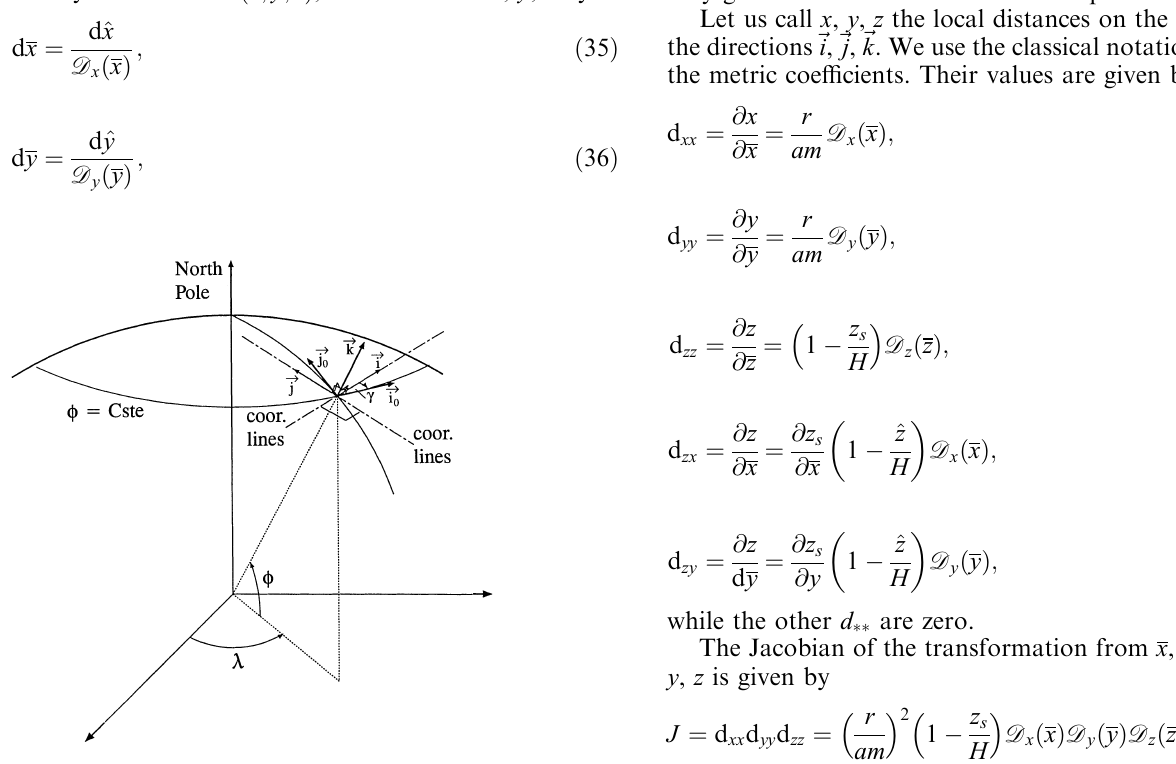
Fig. 1. Principles of projection and notation on the sphere